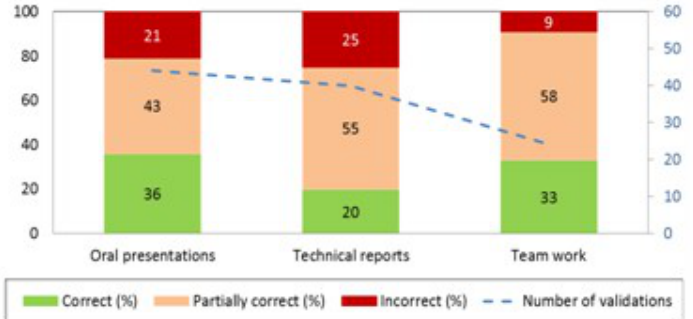
Figure 2. Number of validatons collected and percentage of